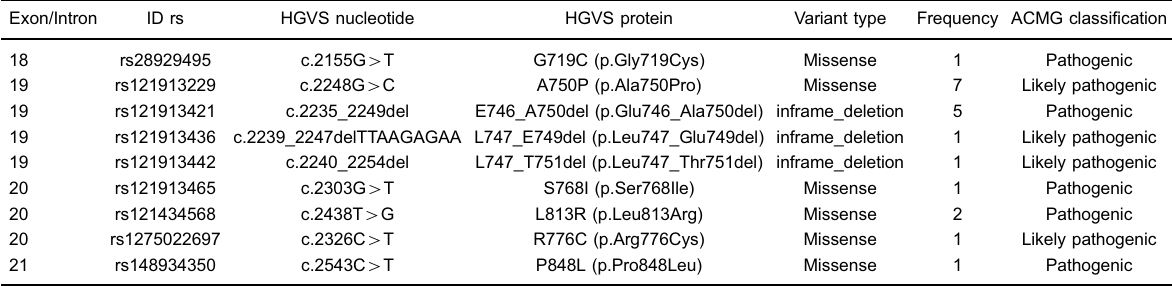
Table 2. Spectrum of EGFR variants in exons 18 – 21 identi fi ed in a Brazilian NSCLC cohort by Next-Generation